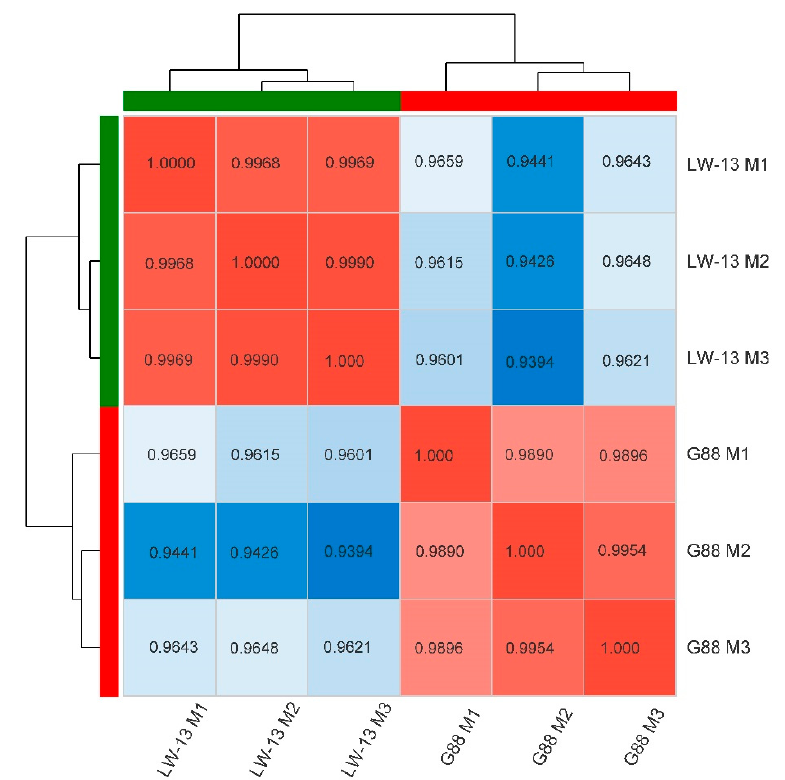
Figure 1. Correlation coefficient heatmap of gene expressions between different samples of P. xylostella . The green bar outside the heatmap represents the LW-13 group; the red bar outside the heatmap represents the G88 group; the values in square frames with red and blue color represent the Pearson correlation coefficients of LW-13 and G88, respectively; the darker color indicates the bigger value.